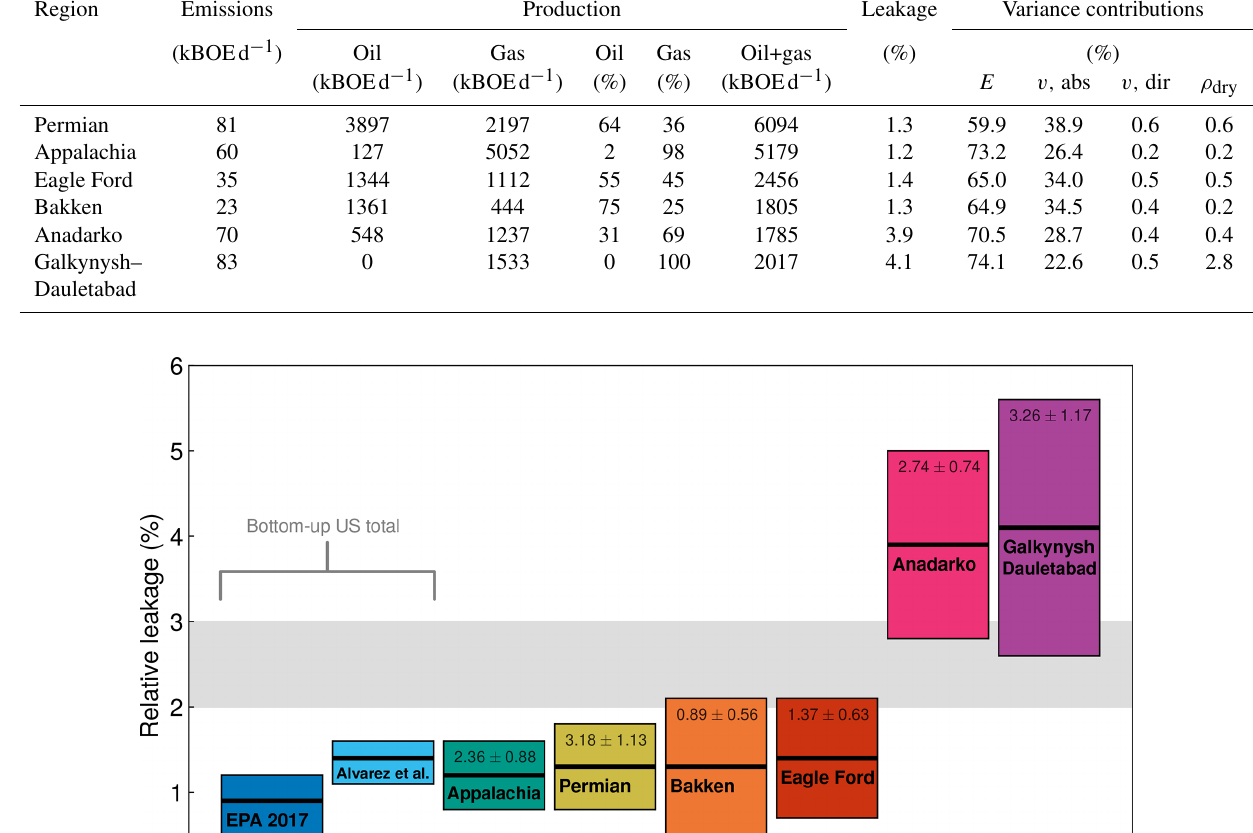
Table 1. Summary of the emission and production values used to determine the leakage rates (emissions divided by combined oil and gas production). All values have been converted (kBOEd − 1 ) as described in Sect. 2. Also shown are the mean percentage variance contributions to the emission estimates for the relative uncertainty components of Eq. (2).